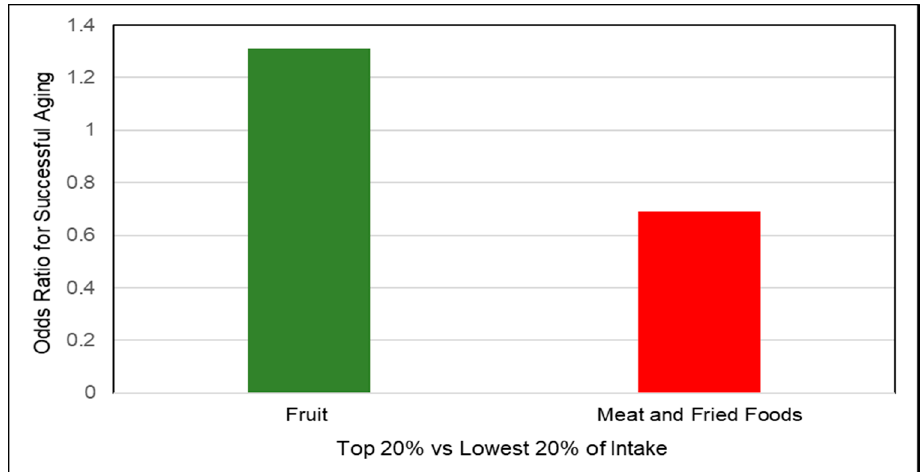
Figure 20. Effect of key dietary pattern food items associated with the odds of successful aging (all p -trend across quintile groups = 0.001) [281].